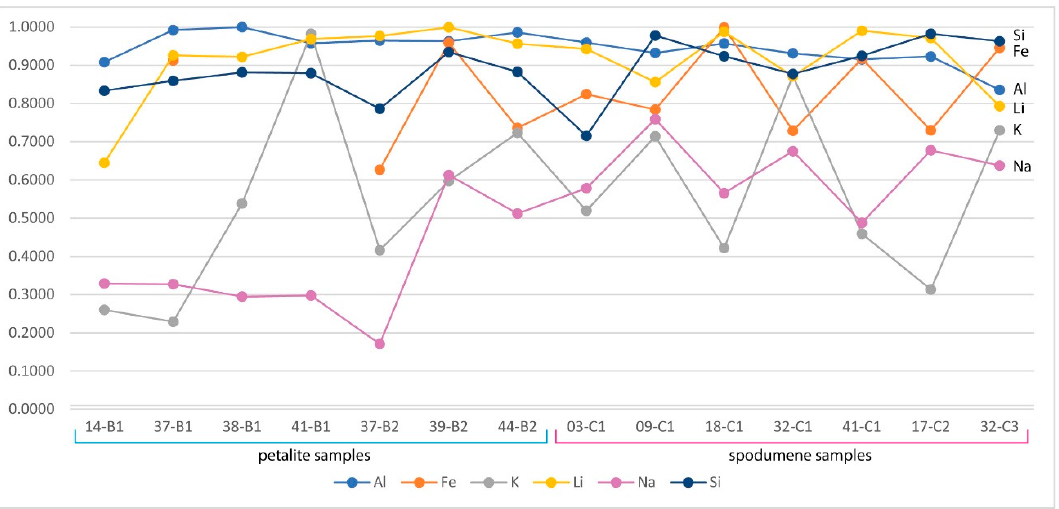
Figure 22. LIBS accuracy compared to the ICP-MS analysis for the spodumene and petalite samples from the Barroso–Alvão aplite-pegmatite fi eld.